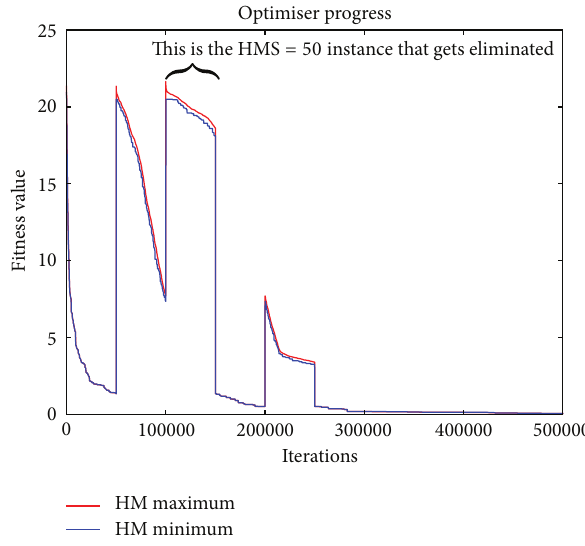
Figure 7: This graph traces the convergence of the GAHS algorithm over 500,000 iterations as it minimises Ackley’s function. The fitness value, which is simply the candidate evaluated using Ackley’s function, of the best and worst candidates in the HM is indidcated at the end of each iteration. The best candiate is the HM minimum indicated by the blue line; the worst candidate is the HM maximum indicated by the red